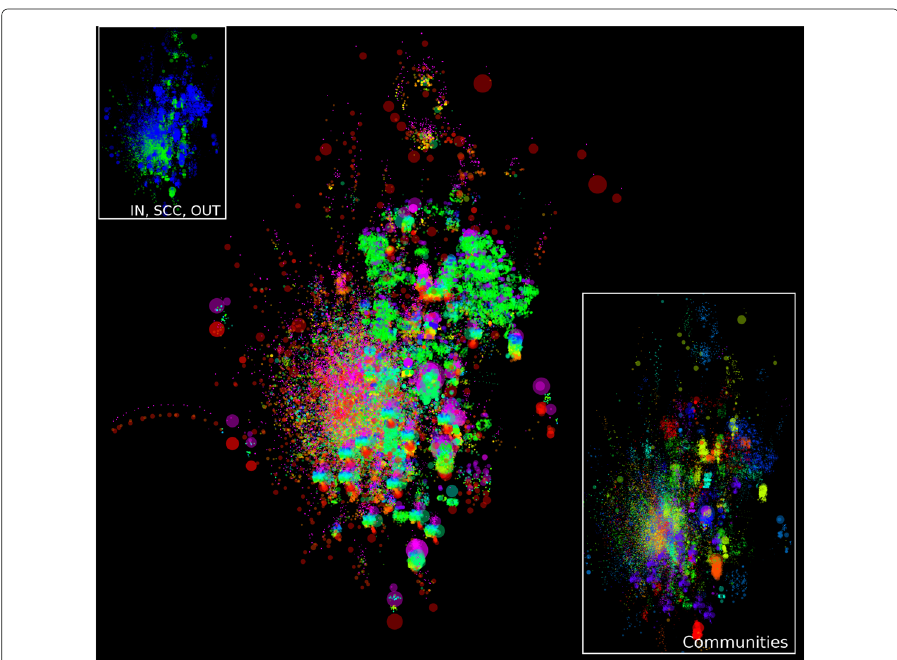
Fig. 8 Bow-tie locality in Notre Dame web network. Lower right inset shows community detection result, and upper left shows only SCC (green) and OUT (blue) segments as the network lacks IN segment. Main plate is colored to the same scheme as Figs. 5 and 7